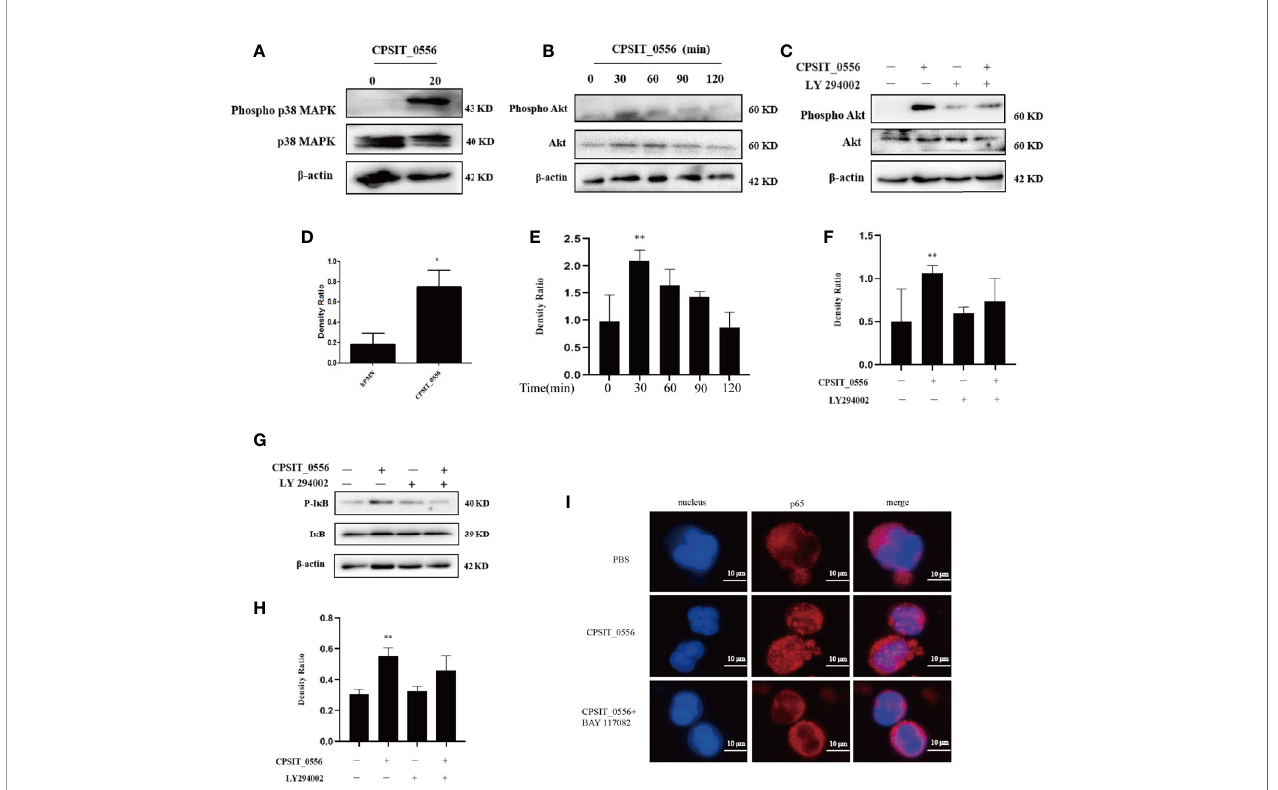
FIGURE 3 | CPSIT_0556 activates the p38 MAPK, PI3K/Akt, and NF- k B pathways in hPMN. (A, D) HPMN was cultured with 20 m g/mL CPSIT_0556 for 1 h, the phosphorylation of p38 MAPK was analyzed by Western blotting and quanti fi ed using ImageJ software. (B, E) HPMN was cultured with CPSIT_0556 with for different time points, the phosphorylation of Akt was analyzed by Western blotting and quanti fi ed using ImageJ software. (C, F) HPMN were pretreated with 25 m M LY294002 for 30 min, and then incubated with CPSIT_0556 for 30 min, the phosphorylation of Akt was analyzed by Western blotting and quanti fi ed using ImageJ software. (G, H) HPMN were incubated with or without the PI3K inhibitor LY294002 (25 m M) for 30 min and then cultured with or without 20 m g/mL CPSIT_0556 for 30 min. the phosphorylation of I k B was analyzed by Western blotting and quanti fi ed using ImageJ software, * P < 0.05 vs . control groups, ** P < 0.01 vs . control groups. (I) HPMN were stimulated with CPSIT_0556 (20 m g/mL) for 12 h and stained with mouse anti-p65 mAb (1:200 dilution), and then incubated with Cy3- conjugated goat anti-mouse IgG (1:200 dilution). DAPI staining of the nucleus, the image was obtained with an optical microscope (×1000, in